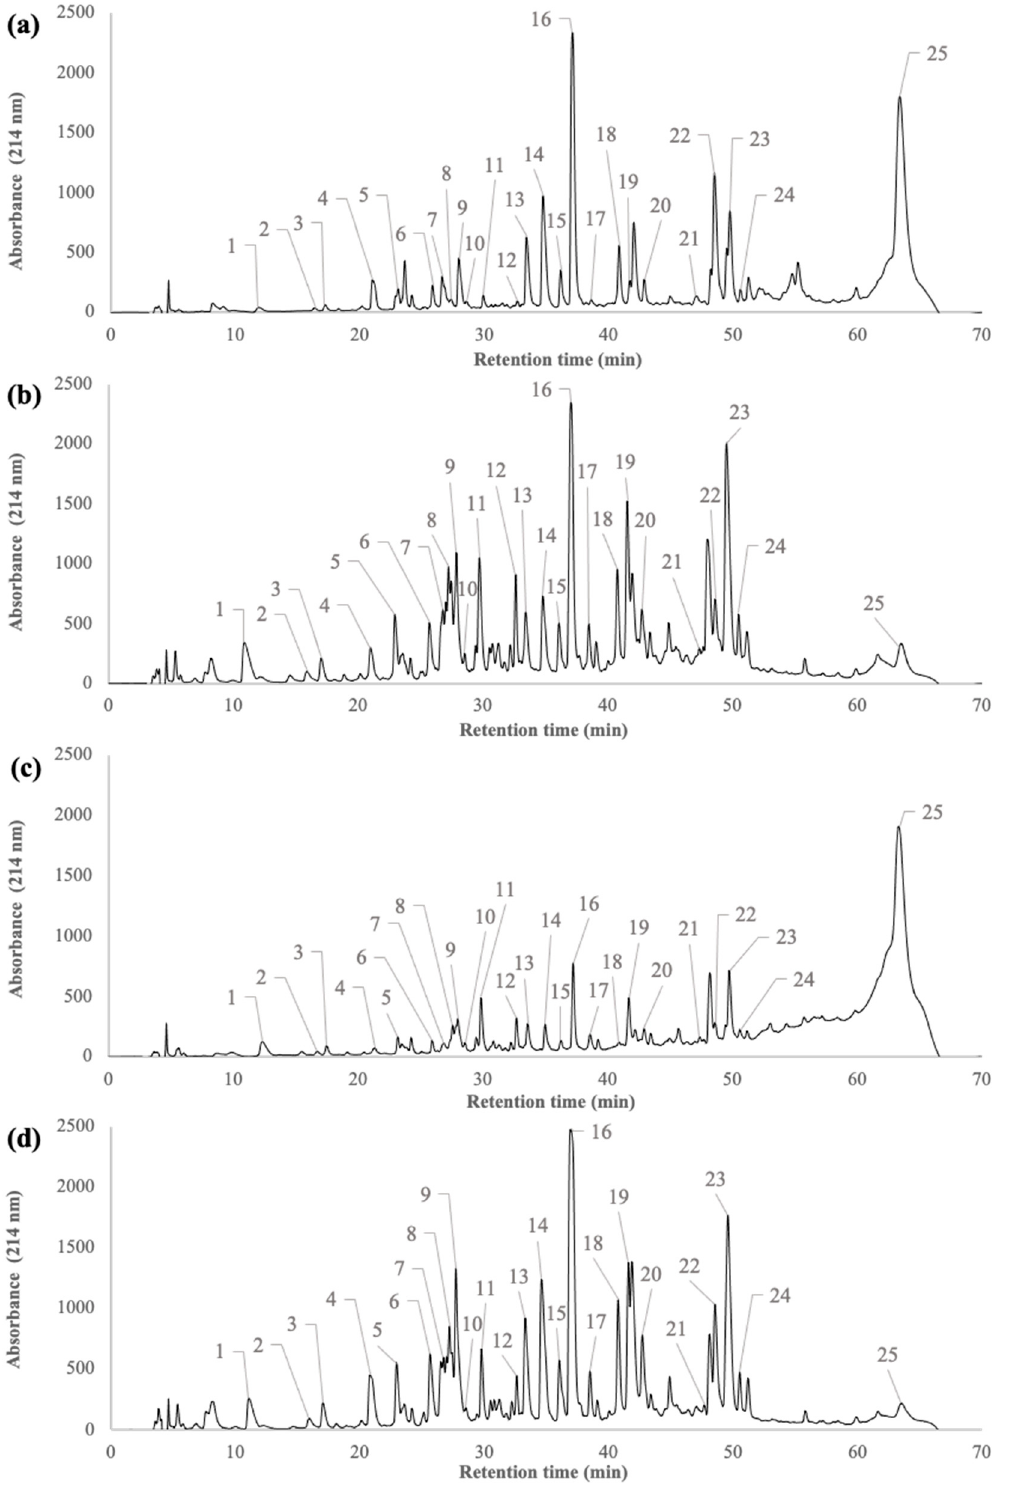
Figure 1. Reverse phase-high performance liquid chromatography (RP-HPLC) chromatograms of the H ( a ), the UFp ( b ), the UFr ( c ), and the ROr ( d ) after the filtration processes. Identification of peptides corresponding to the peak numbers are listed in Table 1. Table 1. Amino acid composition and characteristics of peptides identified in the tryptic hydrolysate and the peptide fractions obtained during filtration (ultrafiltration (UF) and reverse osmosis (RO)) and wash steps.